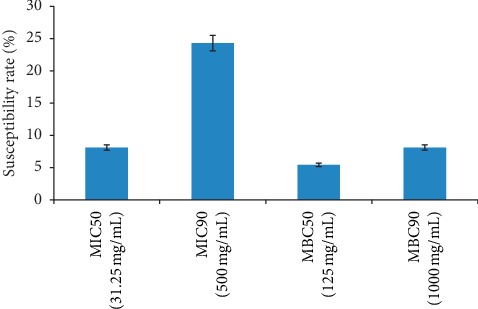
Susceptibility rate of resistant bacilli to Nigerian honey at various MIC and MBC levels.